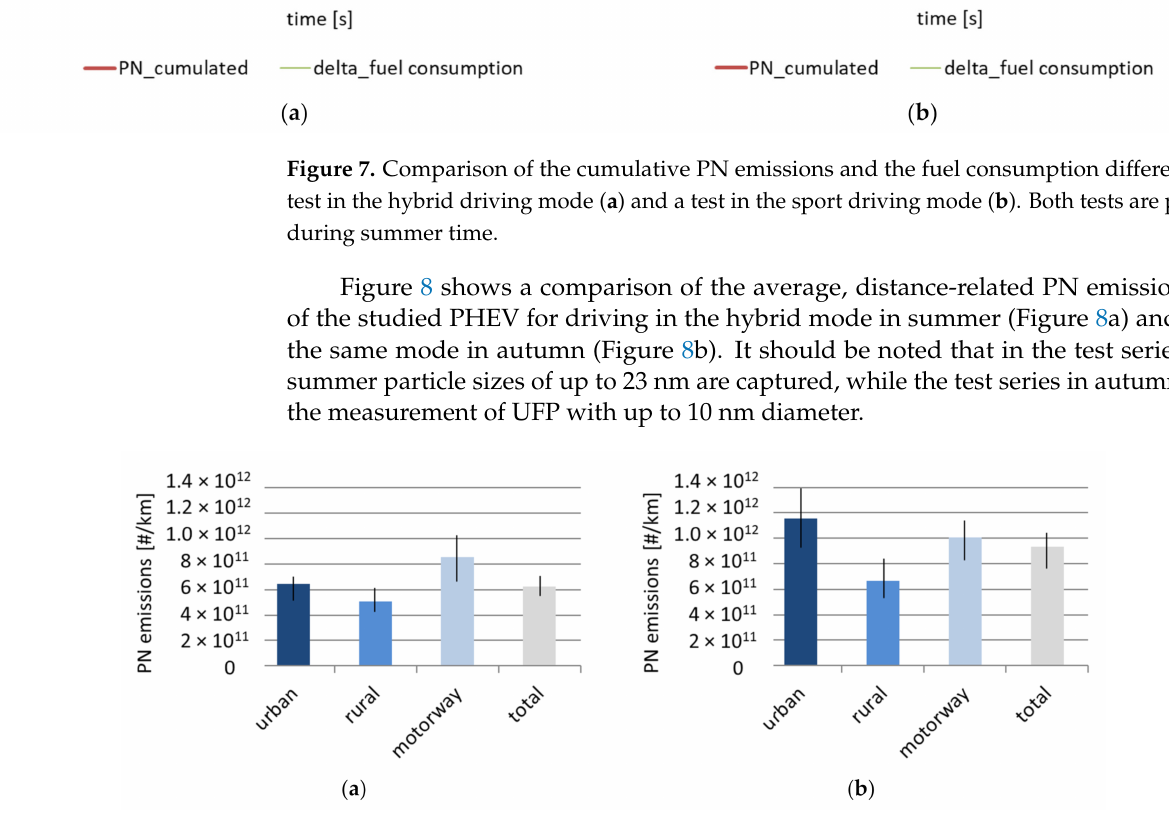
Figure 8. Influence of season and sub-23 nm particle measurement on the real-world PN emissions of the studied PHEV considering hybrid driving mode. ( a ) Summer time; ( b ) autumn time, including ultrafine particle (UFP)